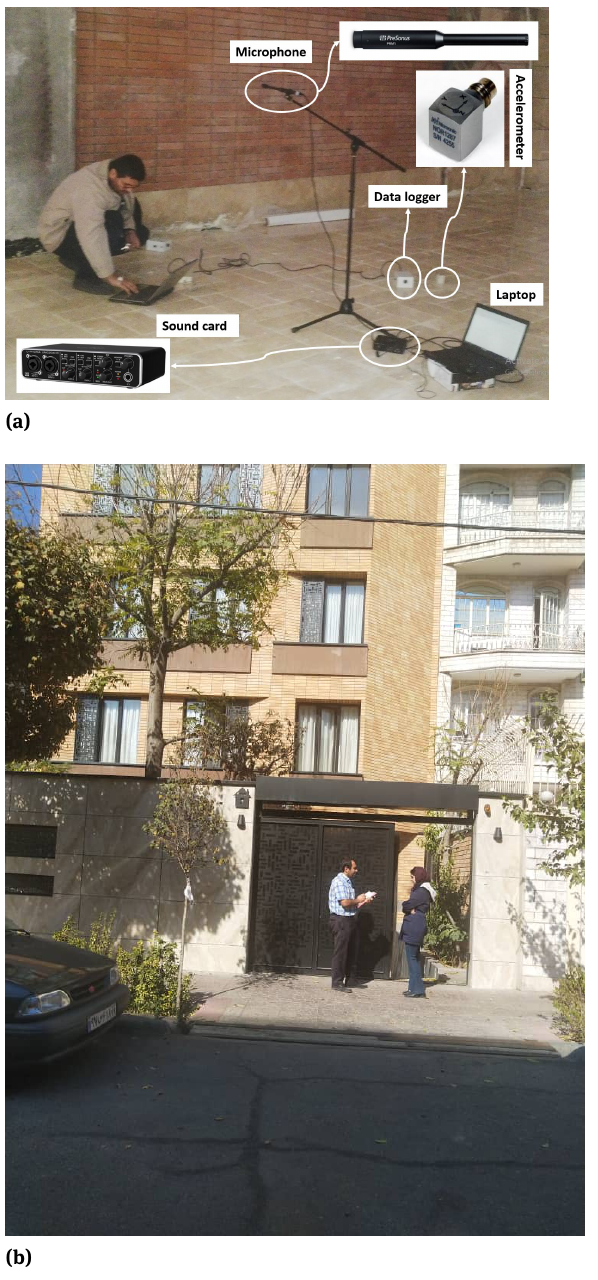
Figure 6: Field research stages, (a) the test setup for measuring SPL and floor vibration and (b) interview with building inhabitants.